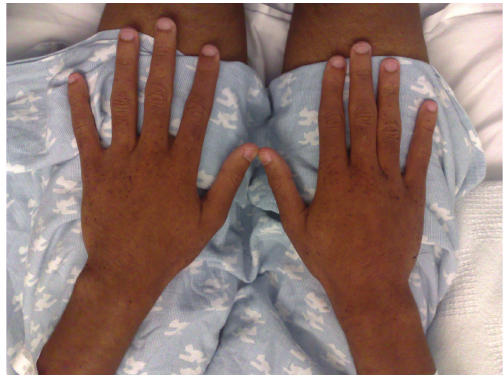
Figure 4: Small bowel biopsy showing preserved villous architec-